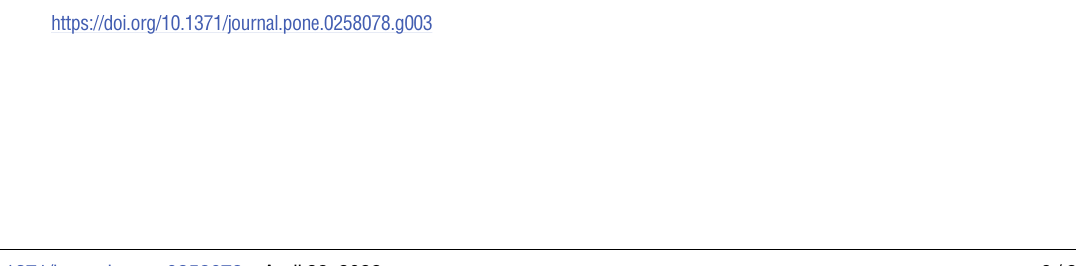
PLOS ONE | https://doi.org/10.1371/journal.pone.0258078 April 28,